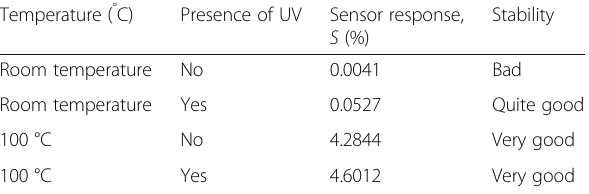
Table 1 Sensor response and stability of hydrogen gas